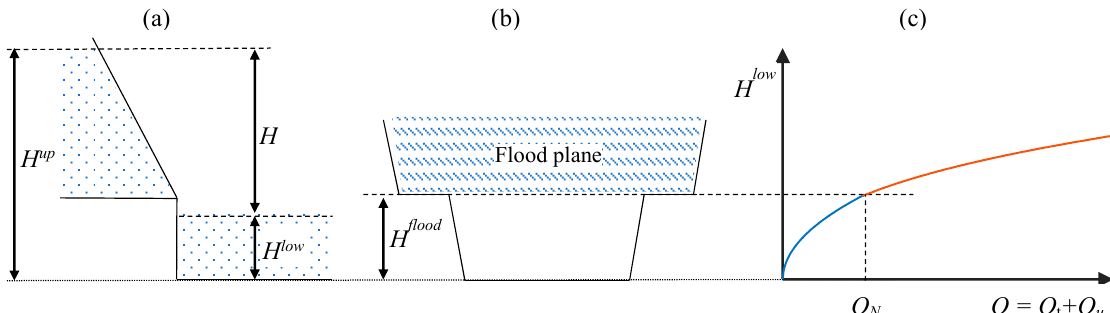
Figure 4. Hydro scheme water levels ( a ), tailrace channel shape and ( b ) tailrace level-discharge relation ( c ).